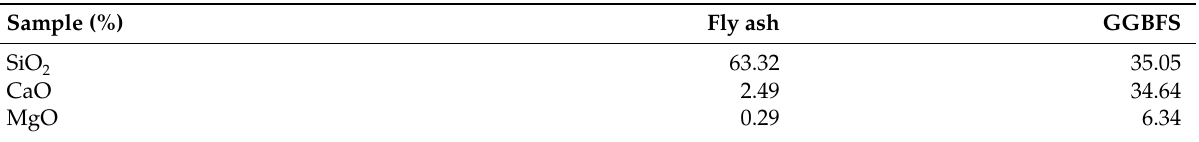
Table 1: Chemical composition for the collected fly ash and GGBFS. Sample (%) Fly ash GGBFS SiO 2